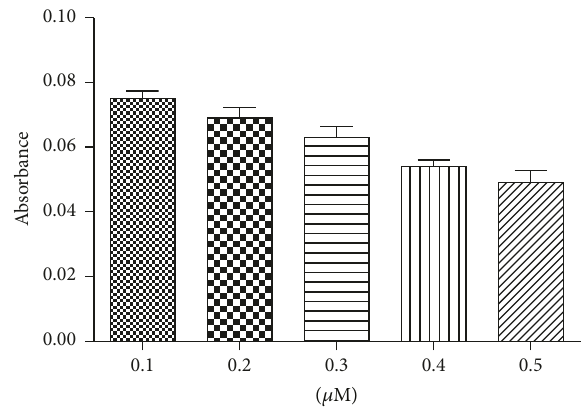
Figure 3: Blockade of peroxidase activity of DNAzyme-aptamer by increasing concentration of B3.